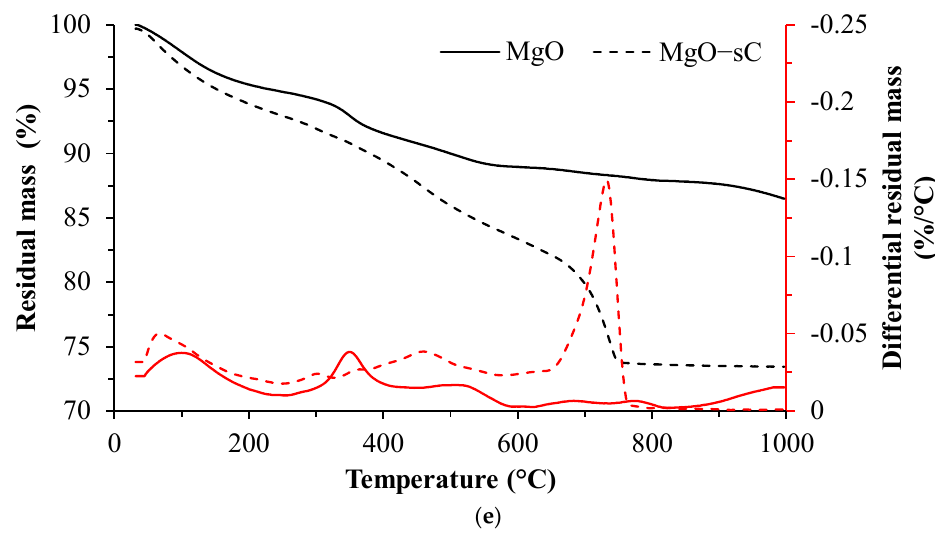
Figure 2. TG/DTG curves of activated slag before and after being exposed to sCO 2 . ( a ) NaOH ( b ) Na 2 SiO 3 ( c ) Na 2 SO 4 ( d ) CaO ( e ) MgO. The dotted lines are for the samples exposed to sCO 2 . In the samples after being subjected to sCO 2 , there is a rapid mass loss up to 200 °C; however, the loss is lower than that of the samples before carbonation in NaOH and Na 2 SiO 3 -activated slag. The lower mass loss of up to 200 °C in sCO 2 -subjected samples indicates the higher bound water in hydrates of uncarbonated samples of NaOH and Na 2 SiO 3 . A small mass loss between 500 to 600 °C corresponds to early decarbonation of carbonates in alkali-activated samples [28,45]. The prominent mass loss peak in sCO 2 -sub- jected samples is visible at 700 °C, which is ascribed to the decomposition of the CaCO 3 . The different polymorphs are converted into calcite when subjected to heating and are subjected to decomposition at similar temperatures [60,61]. The overall mass loss in car- bonated samples is 12–15% higher compared to that of uncarbonated samples for any given activator type. In Na 2 SO 4 samples exposed to sCO 2 , the mass loss peak between 100–